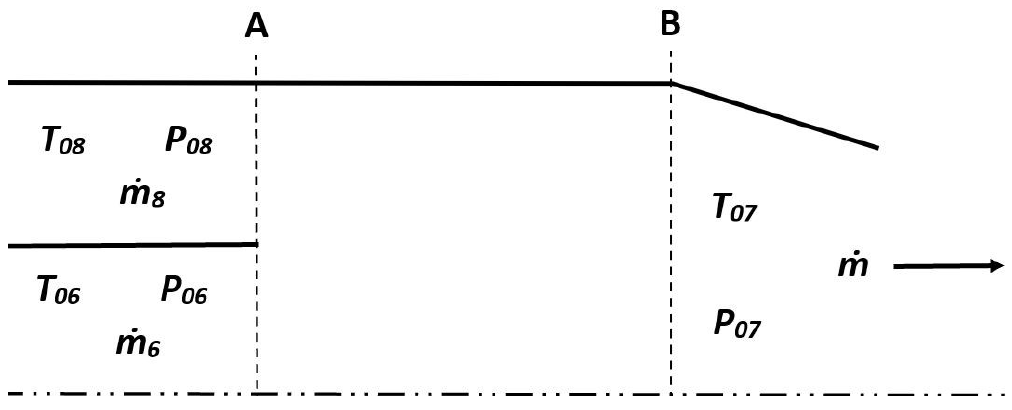
Figure 4. TurboAux Constant-Area Mixing